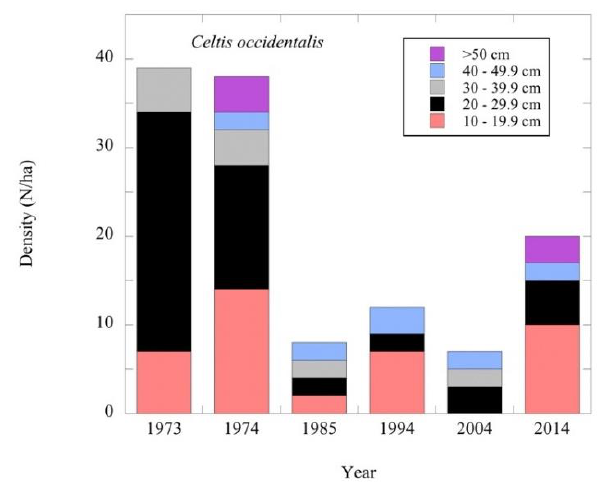
Figure 7. Density (N/ha) distribution by diameter class (DBH ≥ 10.0 cm) of Celtis occidentalis individuals recorded at each of the six sampling periods at Dinsmore Woods.